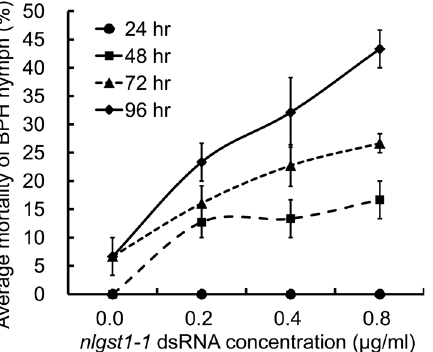
Figure 4. Effect of nlgst1-1 dsRNA on the mortality of BPH nymphs. nlgst1-1 dsRNA that targets the knockdown of nlgst1-1 in BPHs was dissolved in artificial diets at the indicated concentrations (0, 0.2, 0.4 and 0.8 m g/ml), BPH nymphs were then fed on these liquid diets held in the two layers of Parafilm M in controlled growth chambers (90% r.h., 28 u C, 14 hr photoperiod) for 96 hrs. Fresh diets containing the indicated concentrations of nlgst1-1 dsRNA were changed every day. The diet containing 0.8 m g/ml GFP -dsRNA was used as control (0 m g/ml nlgst1-1 dsRNA). The average mortalities of BPHs with the increase of nlgst1-1 dsRNA concentrations were plotted at 24, 48, 72 and 96 h.p.f. Data represent the means 6 SD from three independent experiments with triplicate groups examined for each treatment in each experiment.